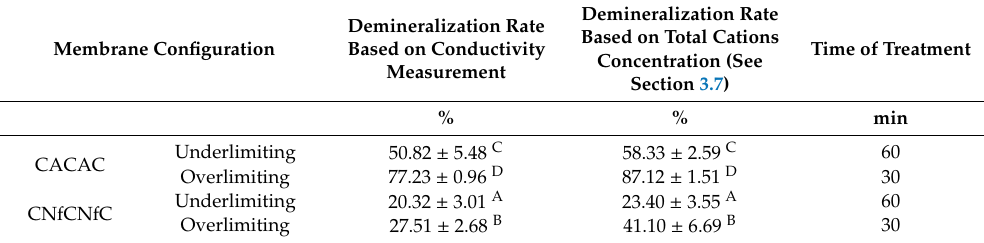
Table 3. Demineralization rate of acid whey (in %) during ED for all configurations and current conditions tested.